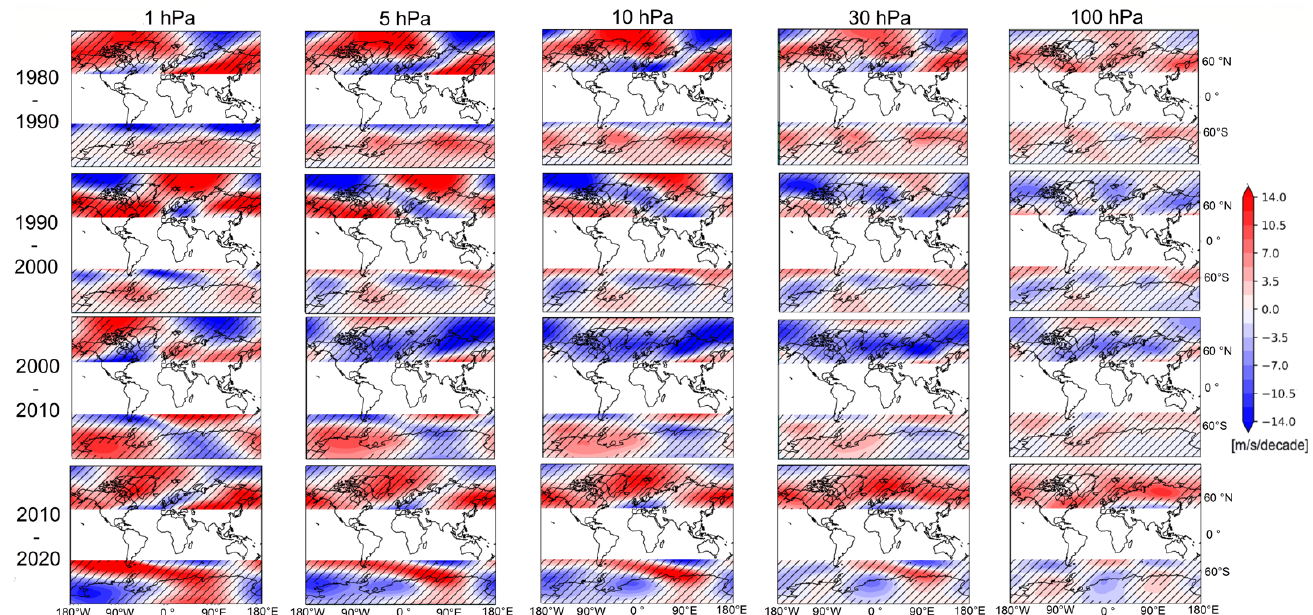
Figure 8. Zonal wind trend (m/s/dec) for 1980–1990, 1990–2000, 2000–2010 and 2010–2020 using ERA5 reanalysis at 1, 5, 10, 30 and 100 hPa.